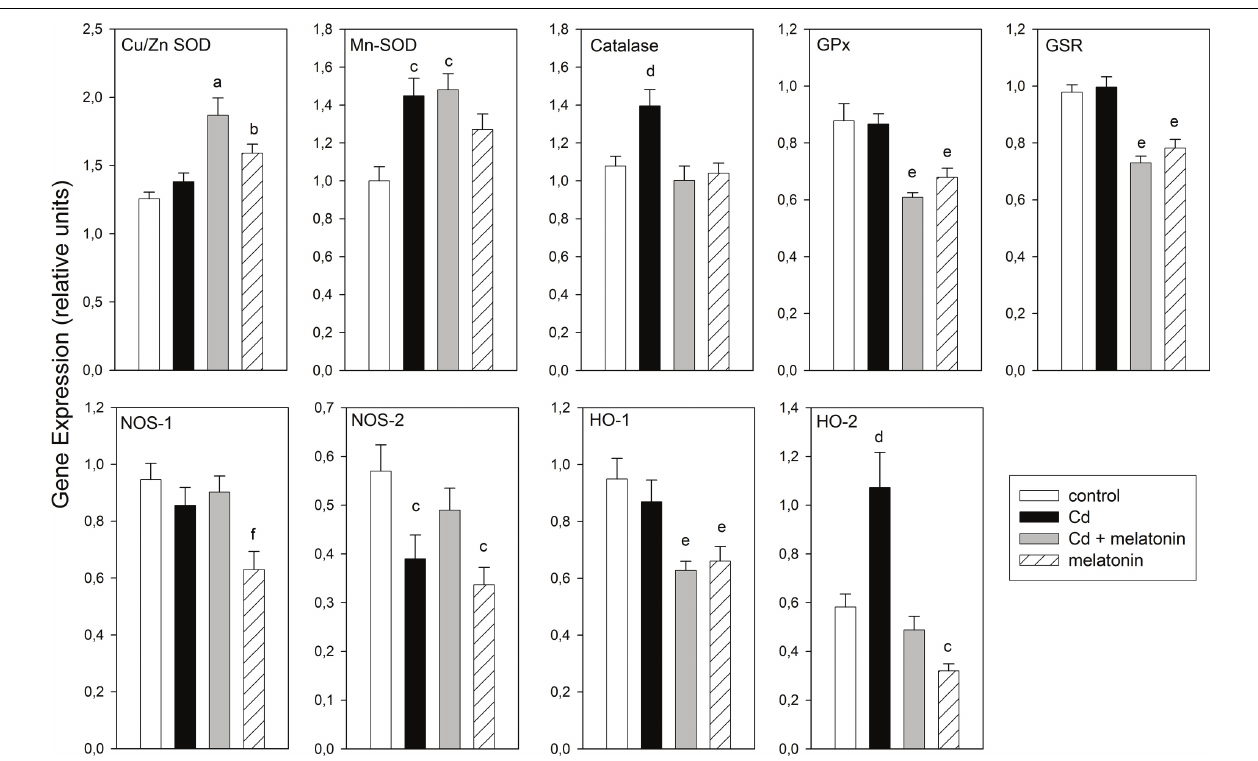
comparison as follows: a p < 0.01 vs. control and Cd groups; b p < 0.05 vs. control; c p < 0.02 vs. control; d p < 0.02 vs. the remaining